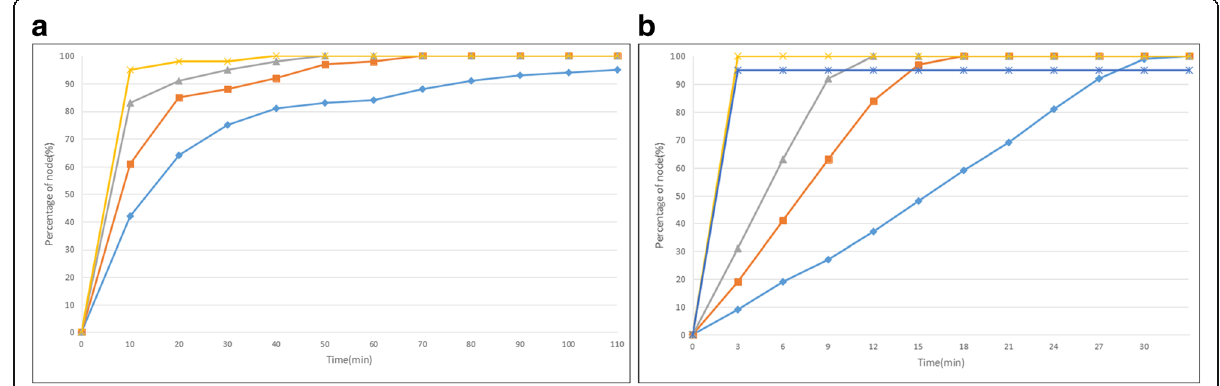
Fig. 9 Efficiency of synchronization for a sparsely deployed network. a The random path case. b The designed path